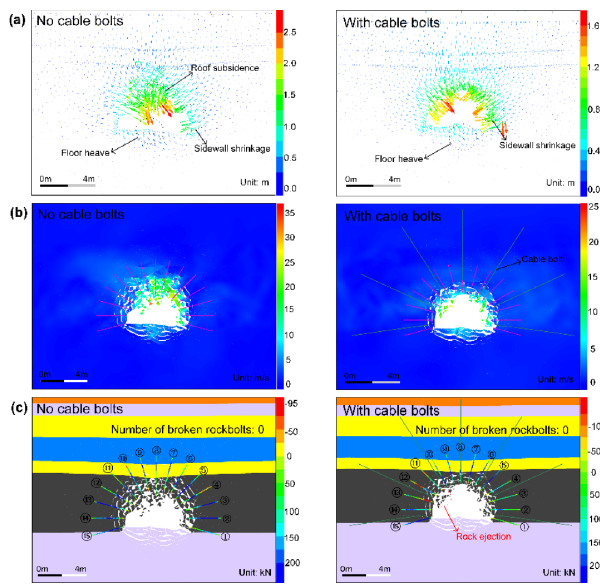
Fig. 25 a , b and c are simulated displacement vectors, velocity dis- tribution, and macroscopic failure patterns of the tunnel and rockbolt axial